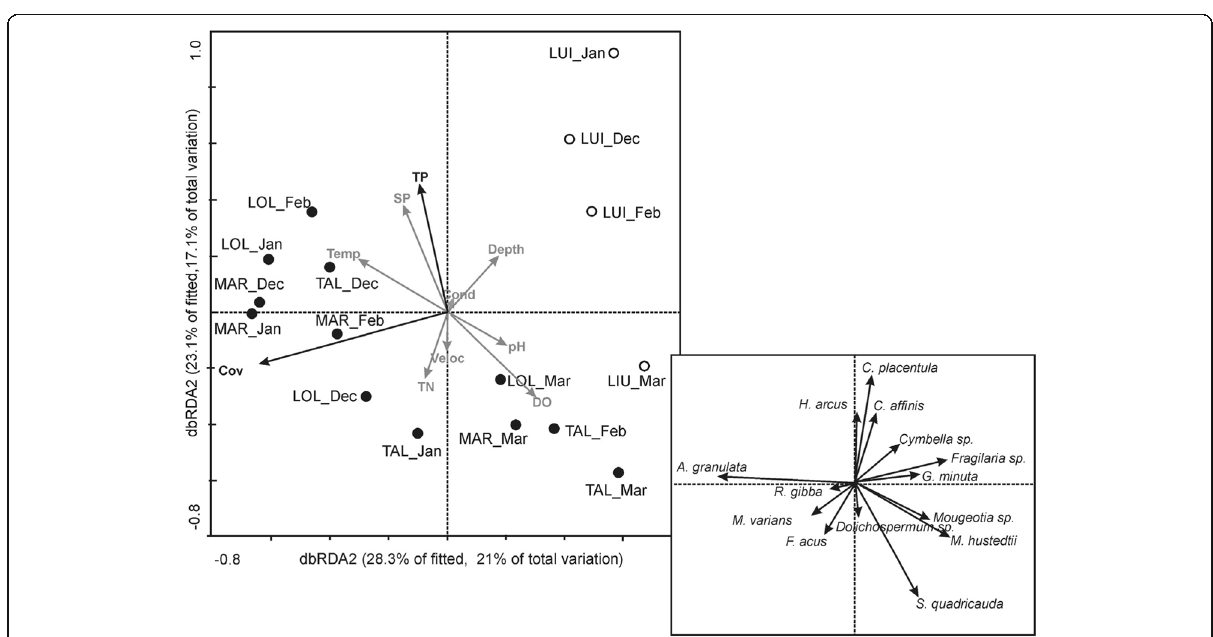
Fig. 4 Distance-based redundancy analysis of phytobenthos community and environmental variables. dbRDA analysis resulting from DISTLM for sampling sites (white circle=site without D. geminata , black circle=sites with D. geminata ). The environmental variables shown are those determined by the coefficient of determination R 2 , with the most significant highlighted. The lower edge shows the taxa that contribute to 60% of the